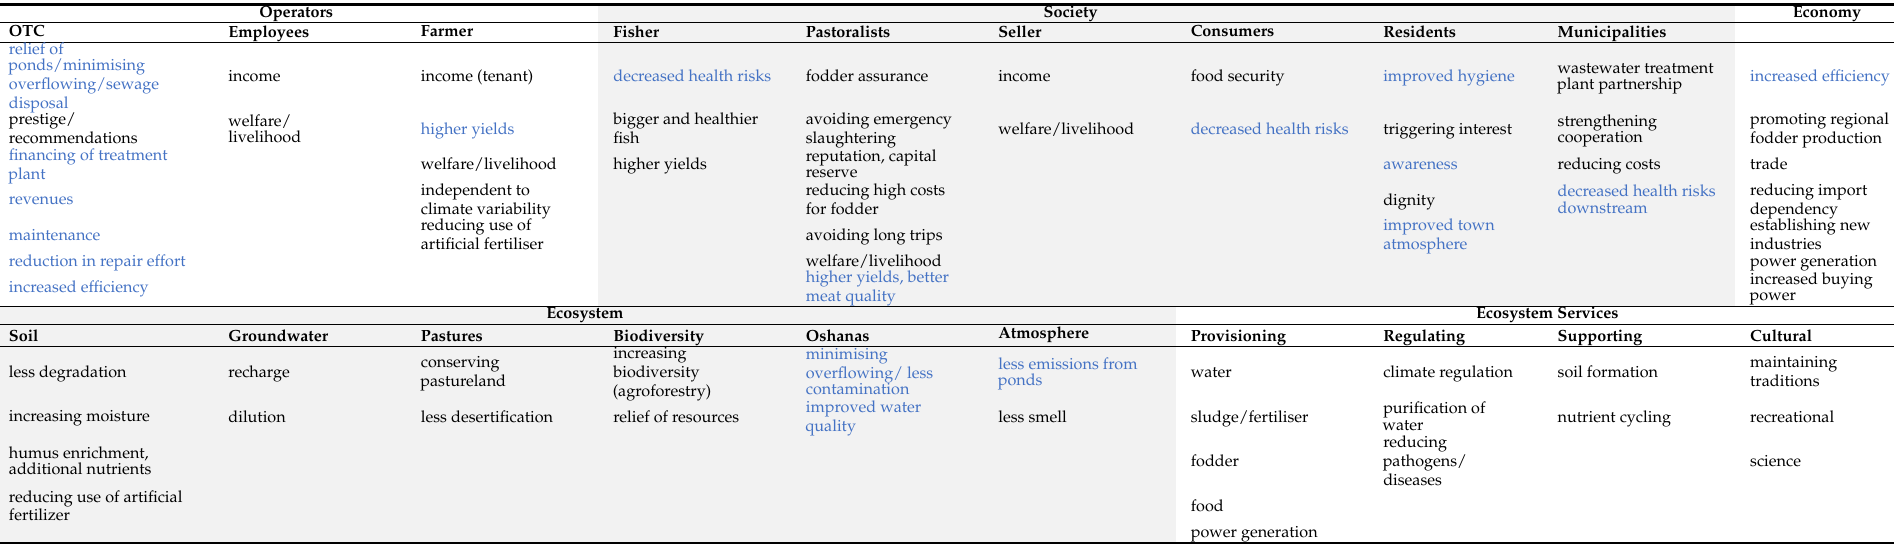
Table 2. Intended impacts of the upgrading process related to poor (black) and good (blue) operation, allocated to spheres of influences.